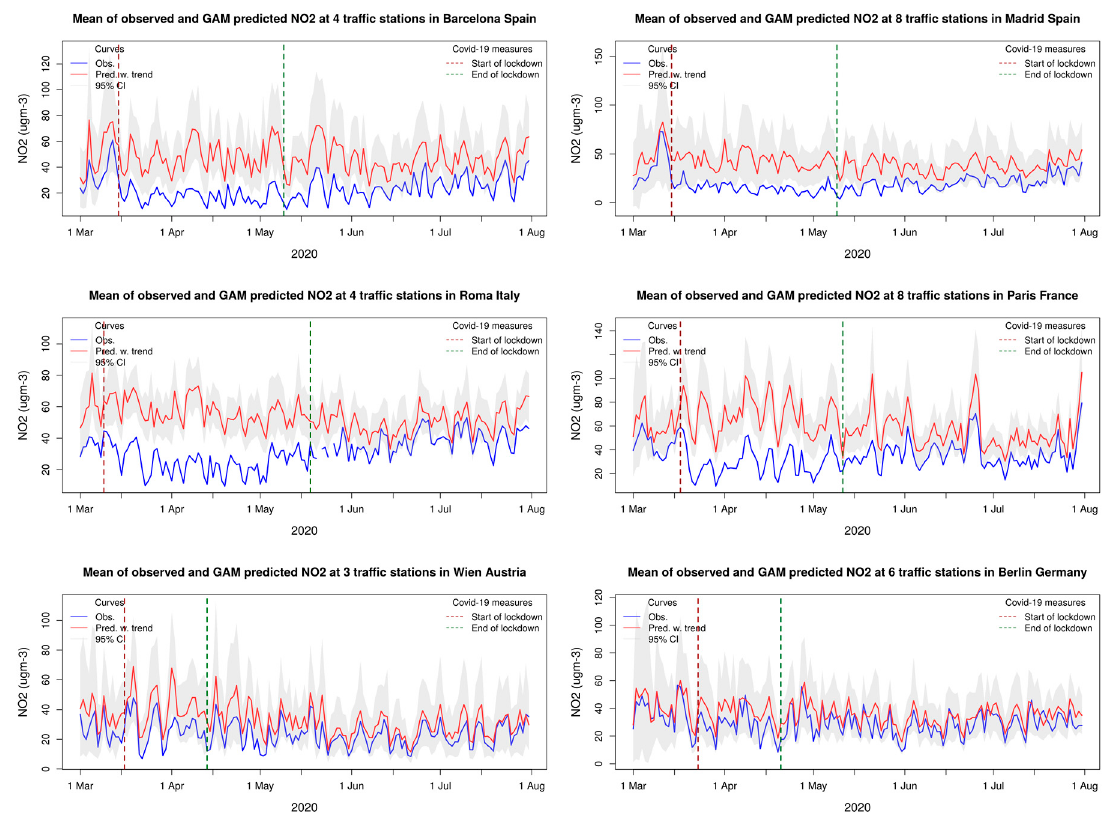
Figure 10. Daily mean NO 2 levels as observed (blue) and predicted (red) by the GAM for traffic stations in Barcelona, Madrid, Rome, Paris, Vienna and Berlin during March–July 2020. The start and end of the lockdown in 2020 are indicated in the plot. Grey shading indicates the 95 percent uncertainty in the prediction interval for each day, as explained in Section